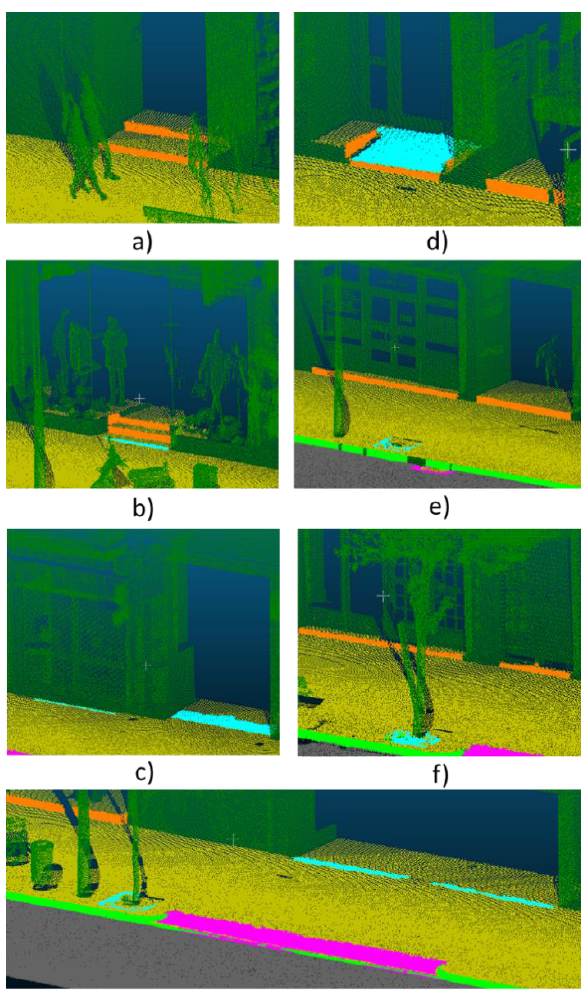
Figure 10. Results. Colour code: steps in orange, ramps in blue, curbs in green, curb-ramps in violet, sidewalks in olive, road in grey and the rest of elements in dark green.